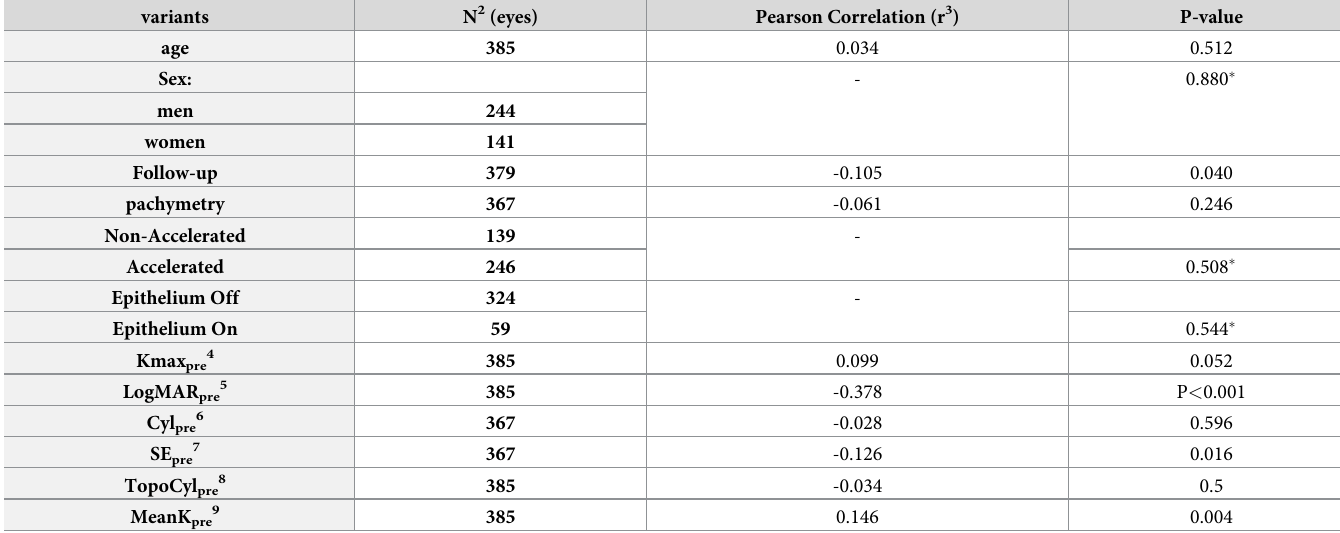
Table 5. Effects of independent variables on Delta LogMAR–Univariate